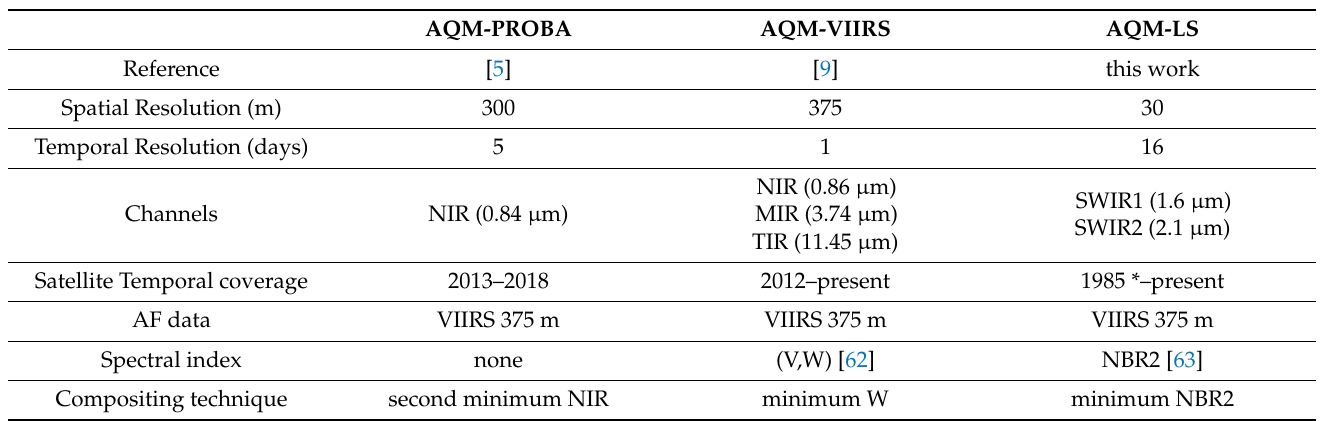
Table 2. Comparison between previous BA algorithms: AQM-PROBA, AQM-VIIRS, and the algorithm developed in this work,